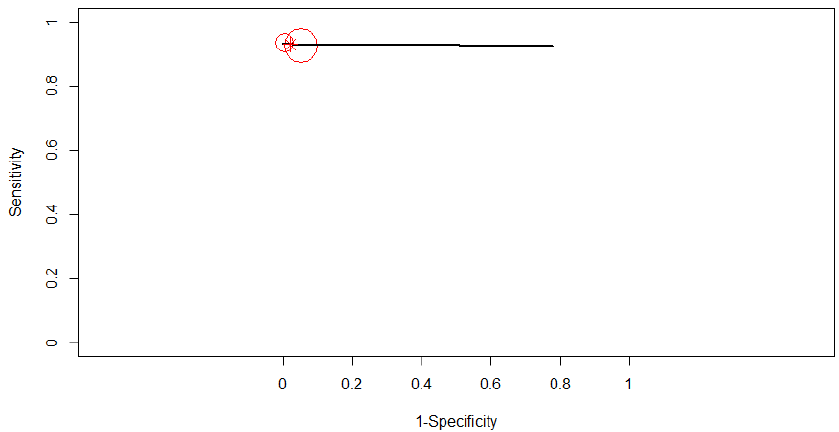
Figure 9. The SROC curve for SVM.